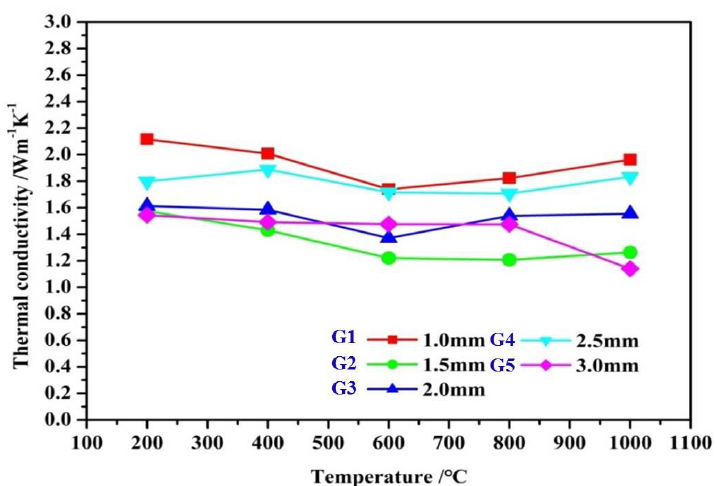
Figure 7. Thermal conductivity of gradient coatings at the different temperature.